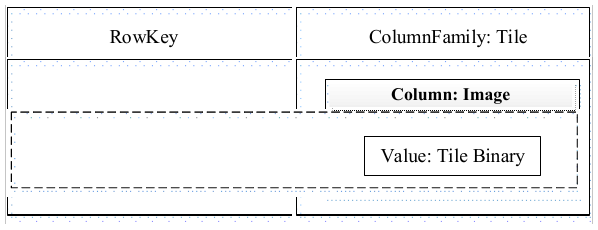
Figure 7. Column-family-based tile data storage model.